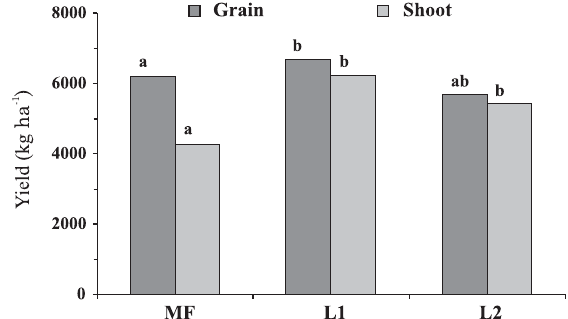
Figure 1. Maize shoot dry matter and grain yields, cultivated during summer 2008/2009, fertilized with mineral fertilizers (MF) and sewage sludge (SS) after seven successive applications of SS at the rates of 10 t ha -1 (L1) and 20 t ha -1 (L2). Means followed by the same letters within each variable do not differ by Tukey test (p <